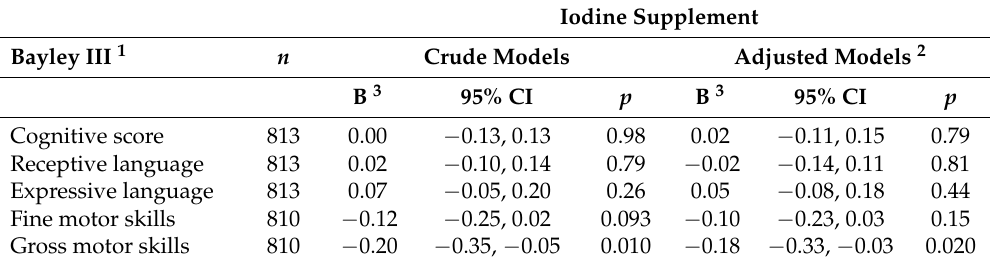
Table 2. Longitudinal regressions of maternal use of iodine-containing supplement and the overall mean of standardized scores on child neurodevelopment. Non-users of iodine-containing supplements serve as reference group.